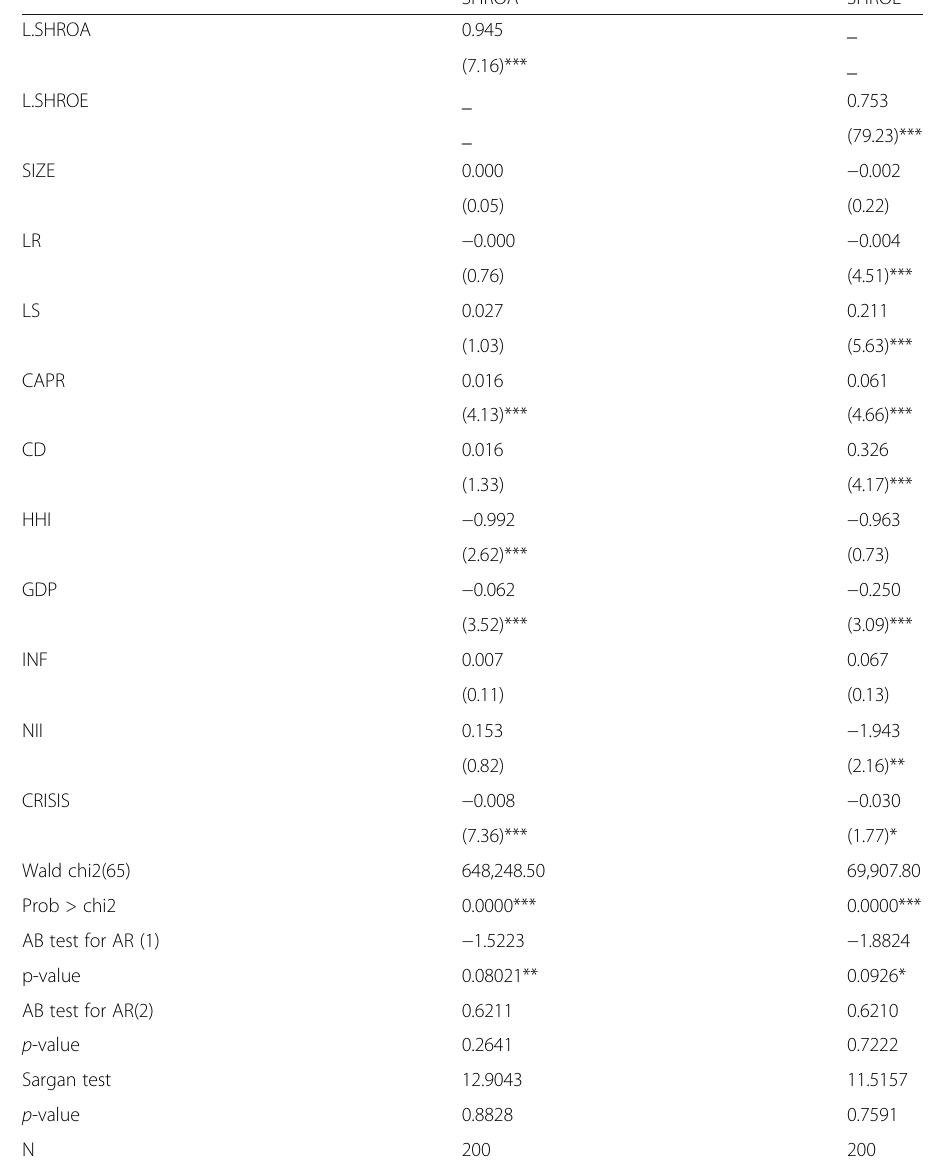
Table 6 Diversification and